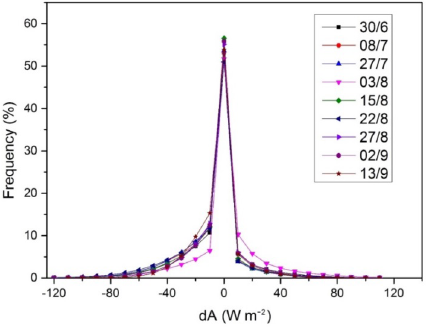
Figure 9. Distribution of the difference AE (dA) and the frequency of the difference for nine